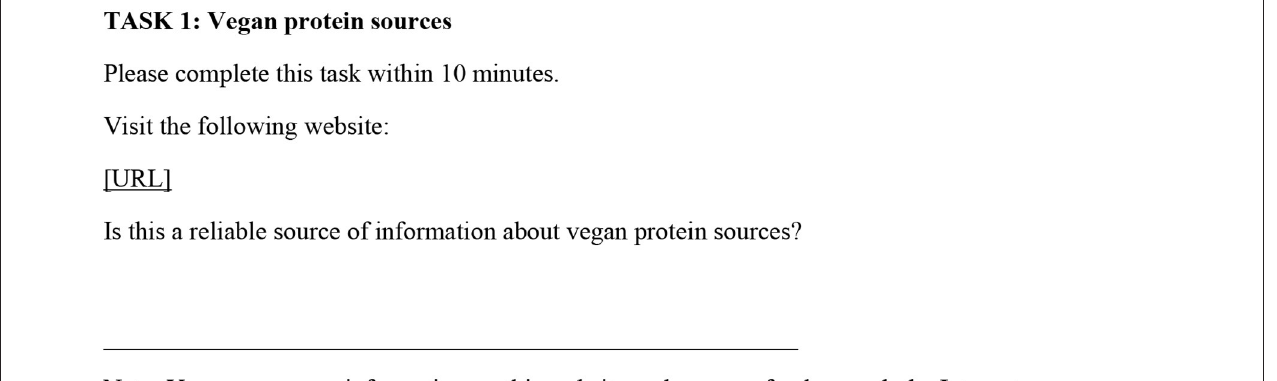
FIGURE 2 | Example CORA Task prompt (German